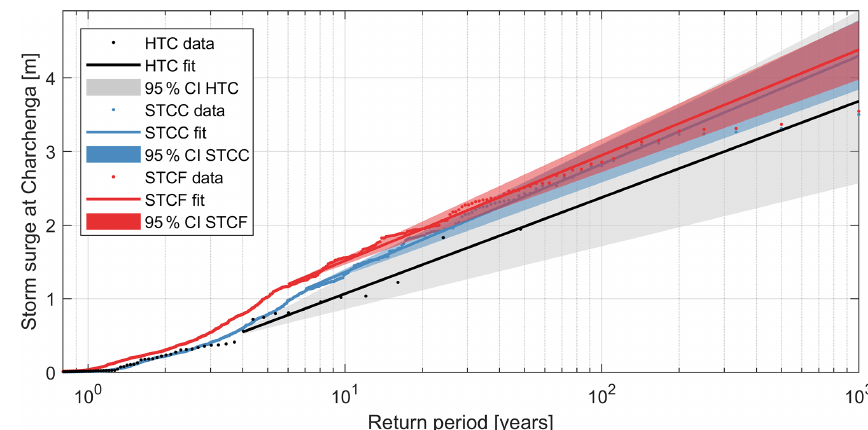
Figure 7. Example of an EVA for storm surge at Charchenga, Bangladesh, for HTCs (black), STCC (blue) and STCF (red). The horizontal axis represents the return period on a logarithmic scale, while the vertical axis represents the storm surge in meters. Shown are the data points with respective return periods (dots), the EVA fit (solid line) and the 95% confidence intervals (colored fills).